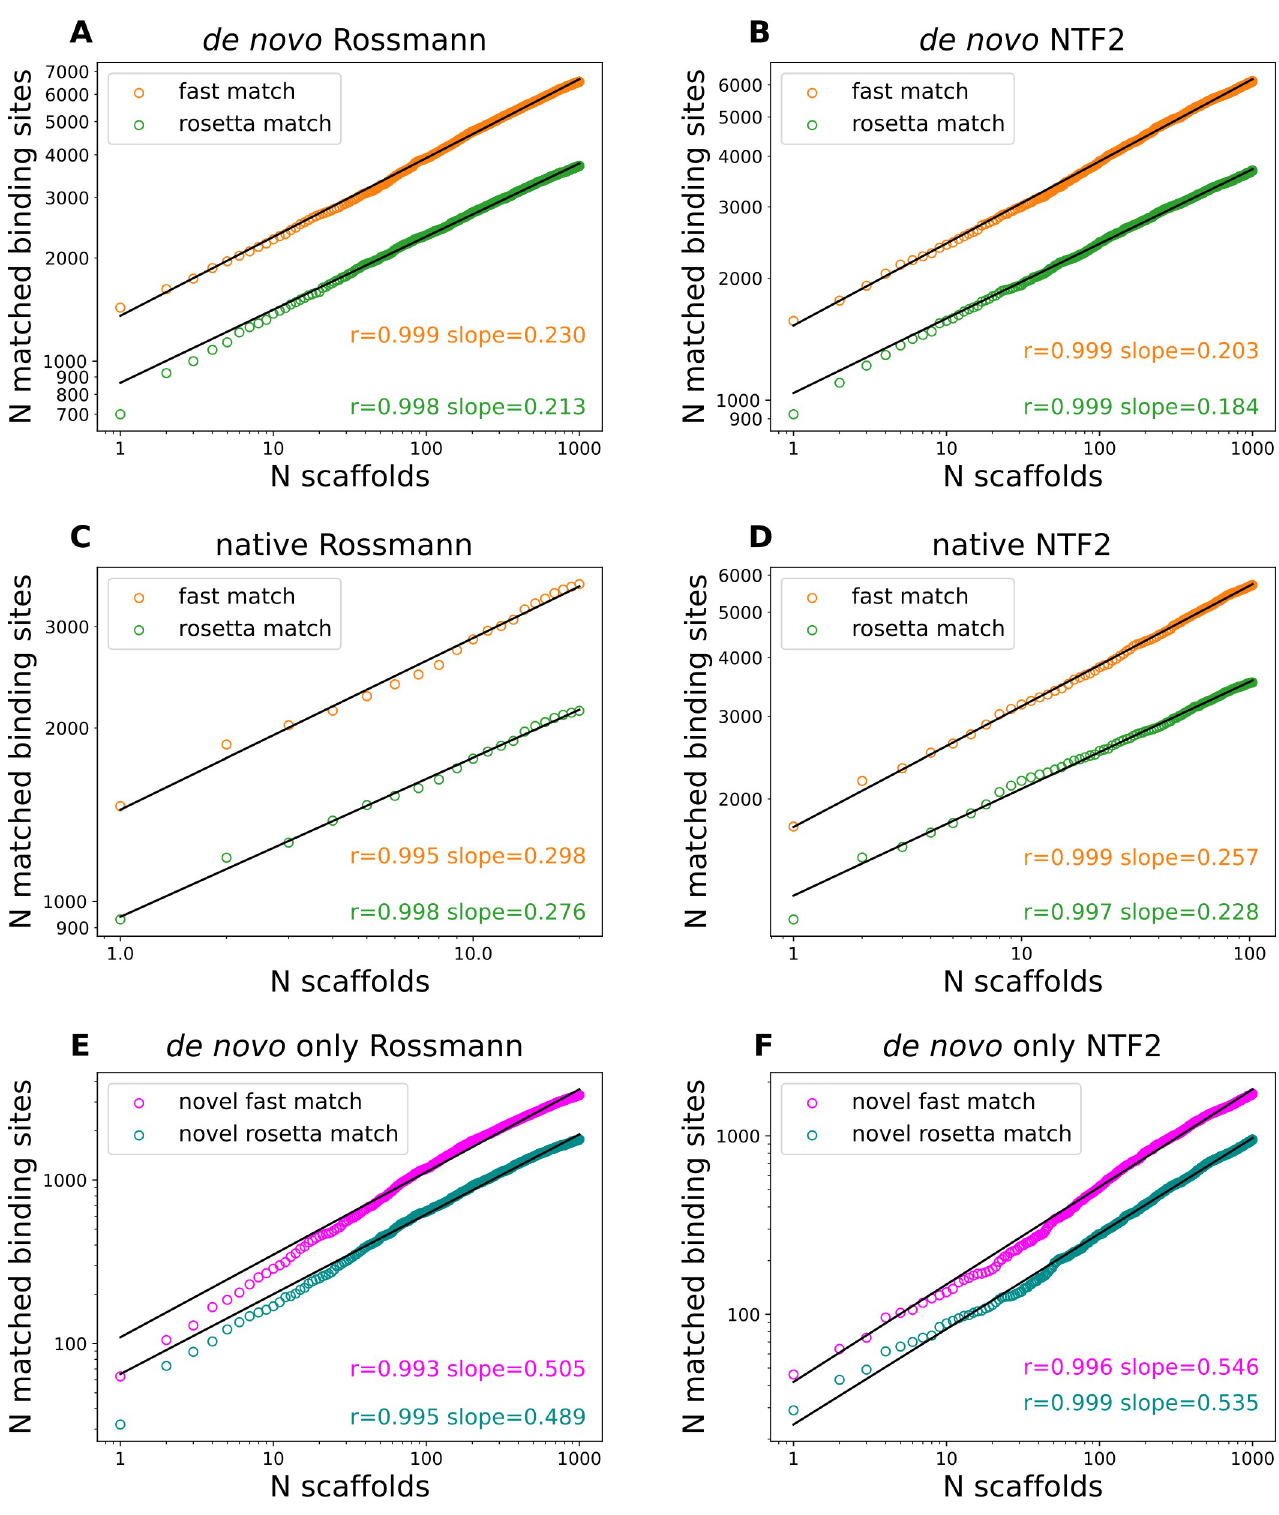
Fig 6. Numbers of matches scale as power-law functions of numbers of scaffolds in fold families. A-D. Log-log plots of the number of 3-residue matches vs the number of scaffolds. E-F. Log-log plots of the number of 3-residue binding sites that can only be matched to de novo scaffolds of specific topologies vs the number of scaffolds. The black lines represent linear